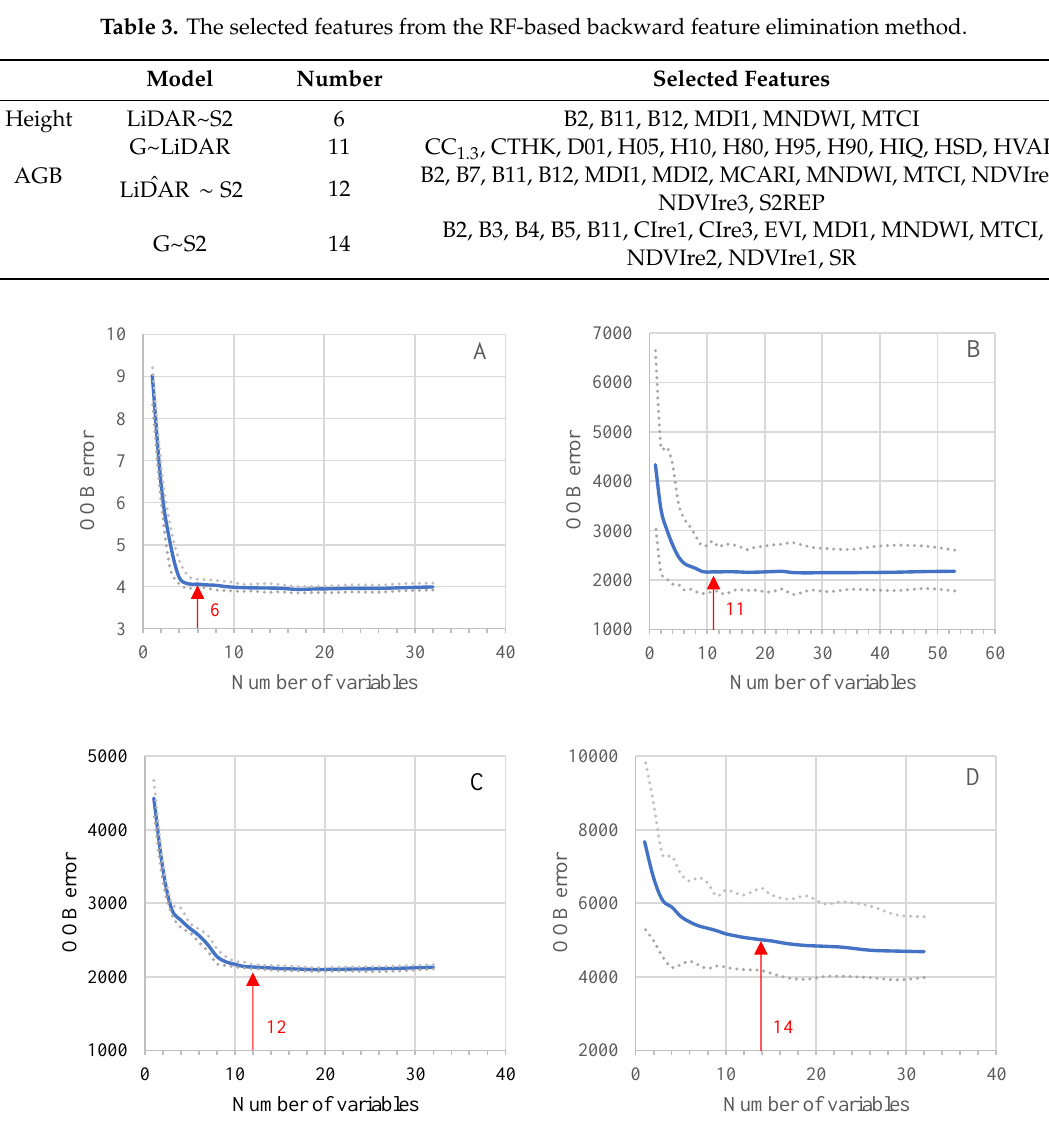
Figure 4. The OOB error versus the number of variables resulting from running the RF-based backward feature elimination method 20 times. ( A ) The LiDAR~S2 model for mangrove height estimation; ( B ) the G~LiDAR model; ( C ) the ˆLiDAR ∼ S2 model; and ( D ) the G~S2 model for mangrove AGB estimations. The optimal number of variables is presented in the